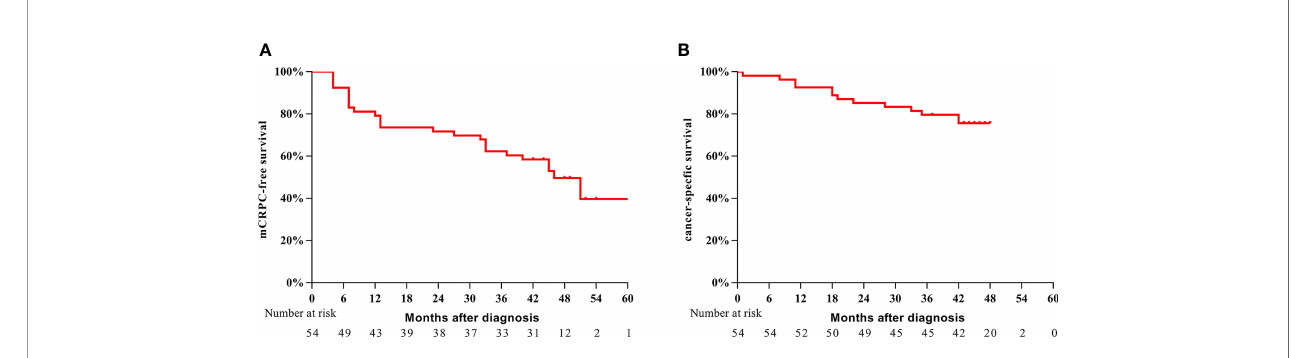
FIGURE 1 | Kaplan – Meier survival analysis of mCRPC-free survival (A) and CSS (B) for the entire cohort of patients.